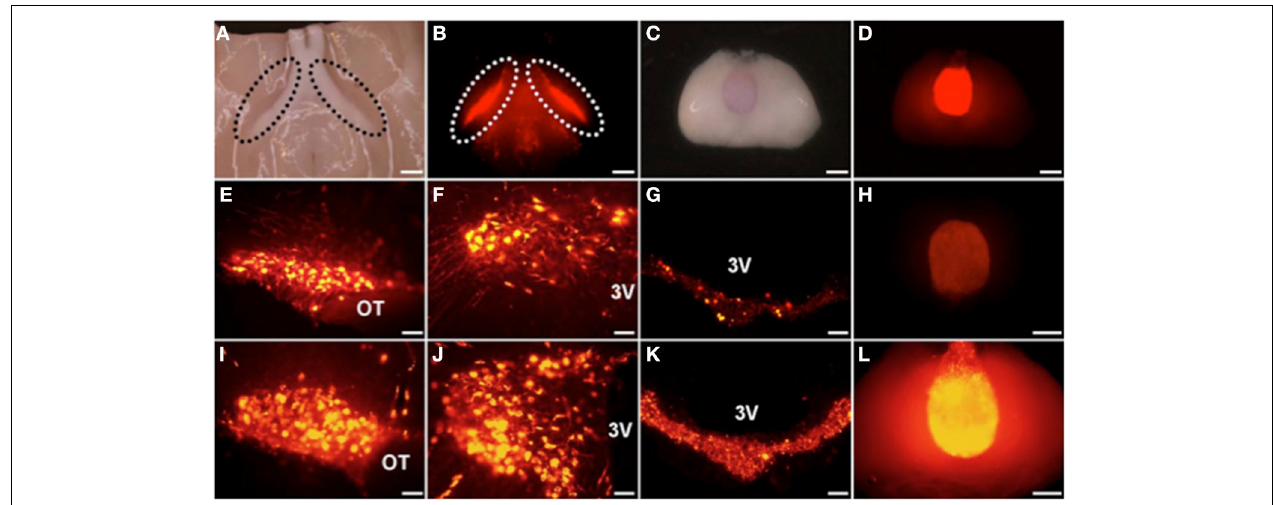
Effectsofsaltloadingfor5daysonthemRFP1fluorescenceoftheSON (I) ,the PVN (J) , the ME (K) , and the PP (L) . Under light (A,C) and fluorescent (B,D–L) .